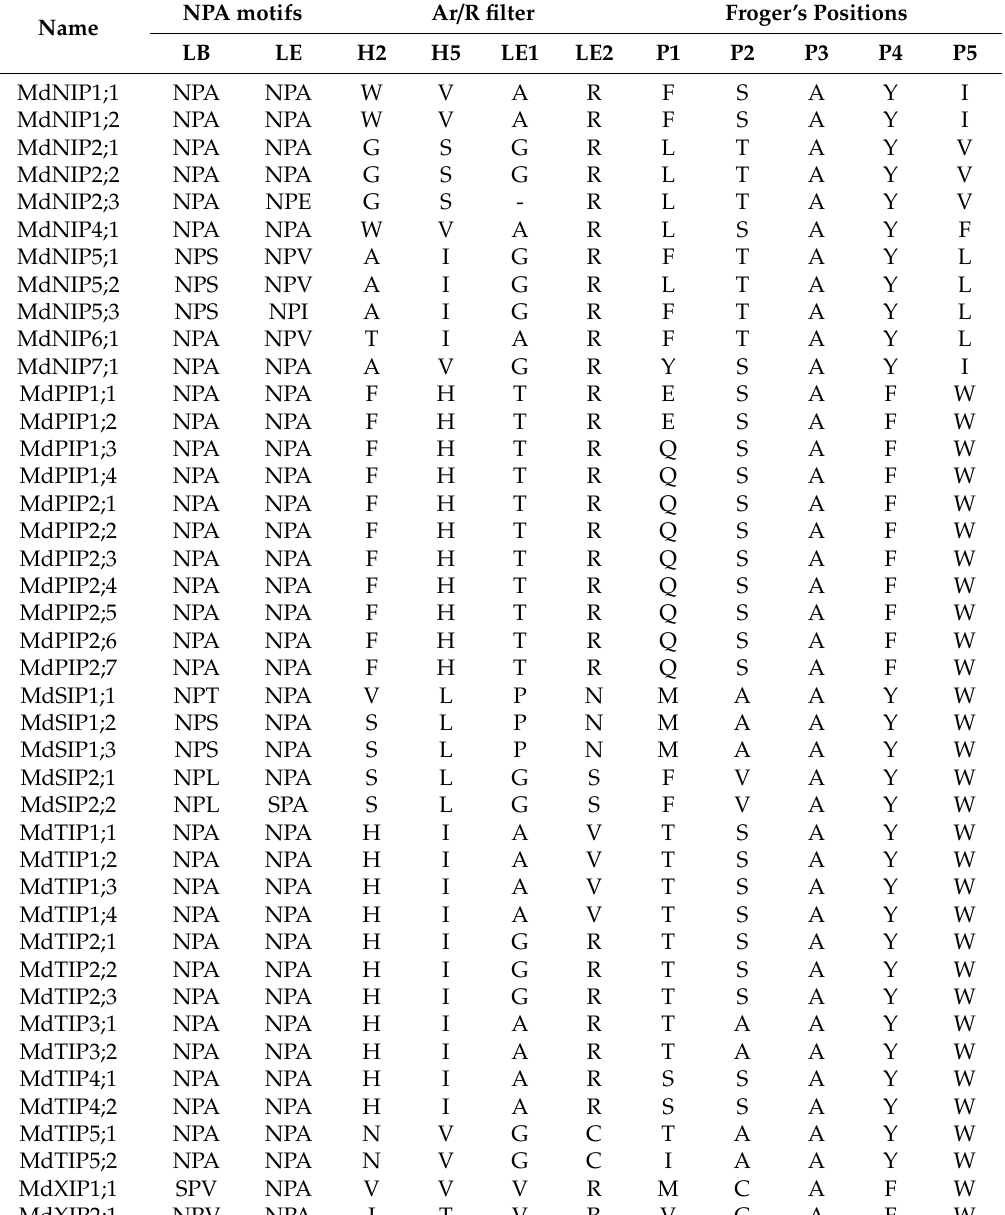
Table 2. NPA motifs, ar / R filter, and Froger’s positons of apple